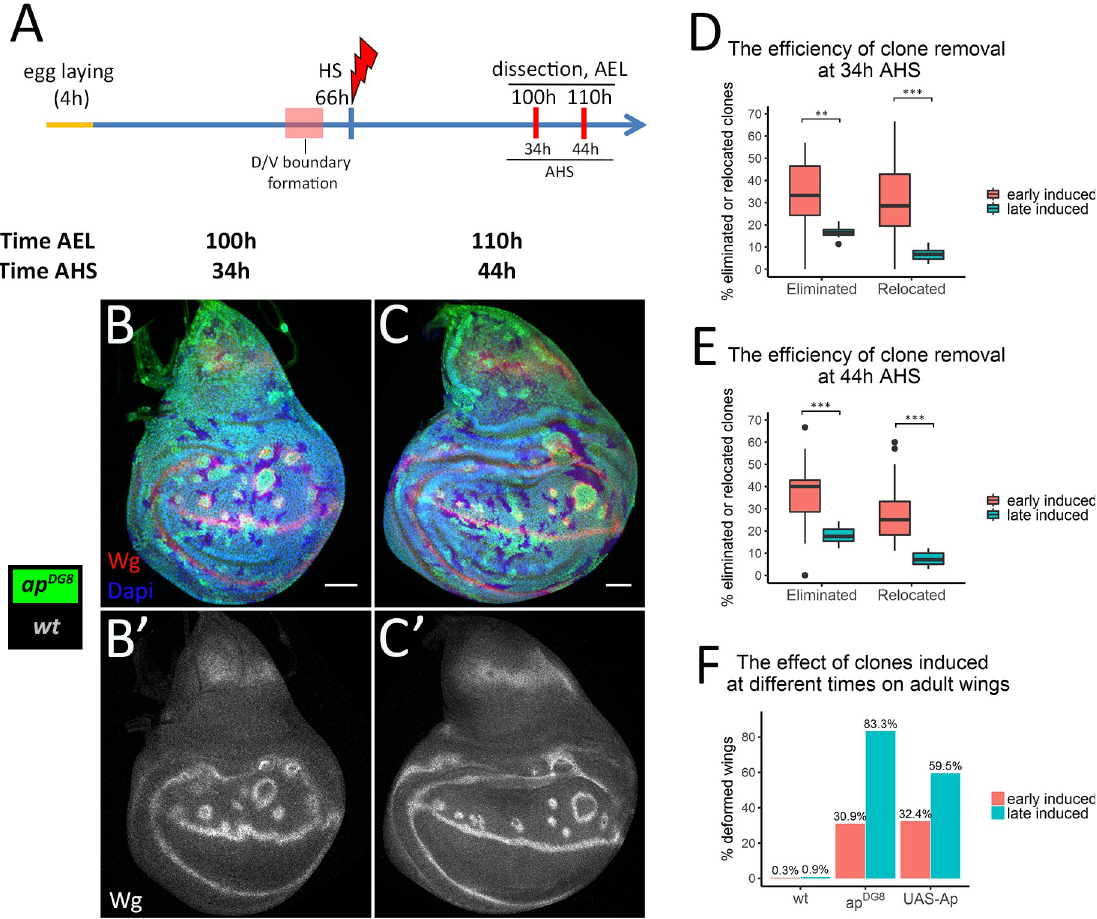
Fig 3. The late induced clones are eliminated less efficiently than the early induced ones. (A) Time-course scheme where clones are induced at 66h AEL. (B-C) Wing discs of indicated times containing differently marked ap DG8 and wild-type clones. (B’-C’) Wg channel alone. (D-E) Comparison of removal of ap DG8 clones that were induced at 46h AEL (“early induced”, shown in Fig 2) with the one of those that were induced at 66h AEL (“late induced”) at 34h (D) and 44h (E) AHS. At least 10 discs with late induced clones were analysed per time point. (F) Percentages of defective wings due to wild-type, ap DG8 and Ap-expressing flip-out clones induced at 46h or at 66h AEL. Numbers of analysed wings: early induced: wt—302; ap DG8 – 304; UAS-Ap– 482; late induced: wt—230; ap DG8 – 102; UAS-Ap– 84. Scale bars represent 50 μ